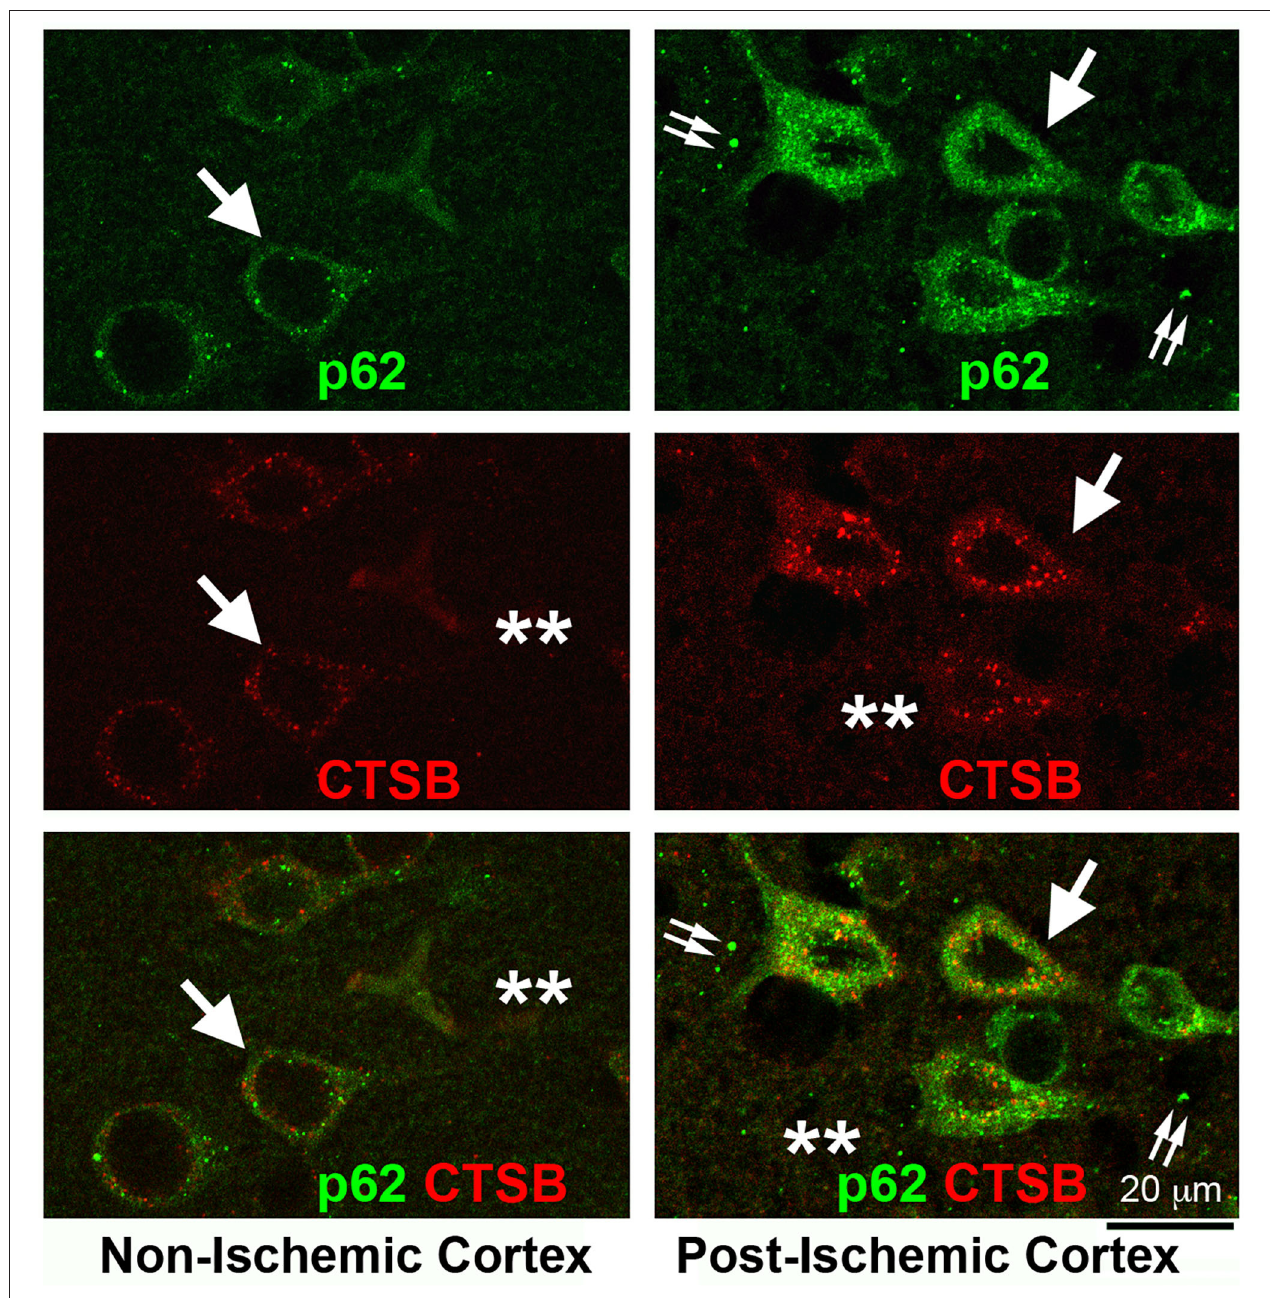
FIGURE 5 | Confocal imaging of neuronal buildup of p62/SQSTM1 and CTSB after stroke. Brain section obtained from a rat subjected to 2h of MCAO followed by 24h of reperfusion, double-labeled with p62/SQSTM1 (green) and CTSB (red) antibodies, and examined by confocal microscopy. Left panels display the contralateral non-ischemic cortex; Right panels show the ipsilateral post-ischemic cortex. Upper row: p62/SQSTM1 immunolabeling; Middle row: CTSB immunolabeling; Lower row : p62/SQSTM1 (green) and CTSB (red) double-immunolabeling. Arrows point to p62/SQSTM1 and CTSB immunolabeling in neuronal soma; double-arrows indicate the p62/SQSTM1 immunolabeling outside of neuronal soma; and stars denote the immunostaining outside of neuronal